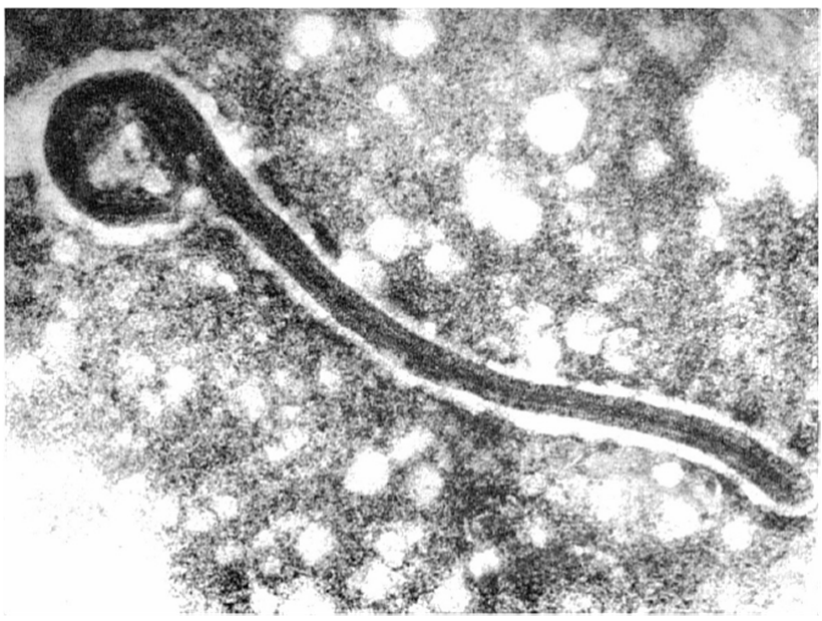
Figure 4. The first electron micrograph of a Marburg virion from 1967. Image courtesy of W. Slenczka, University of Marburg,